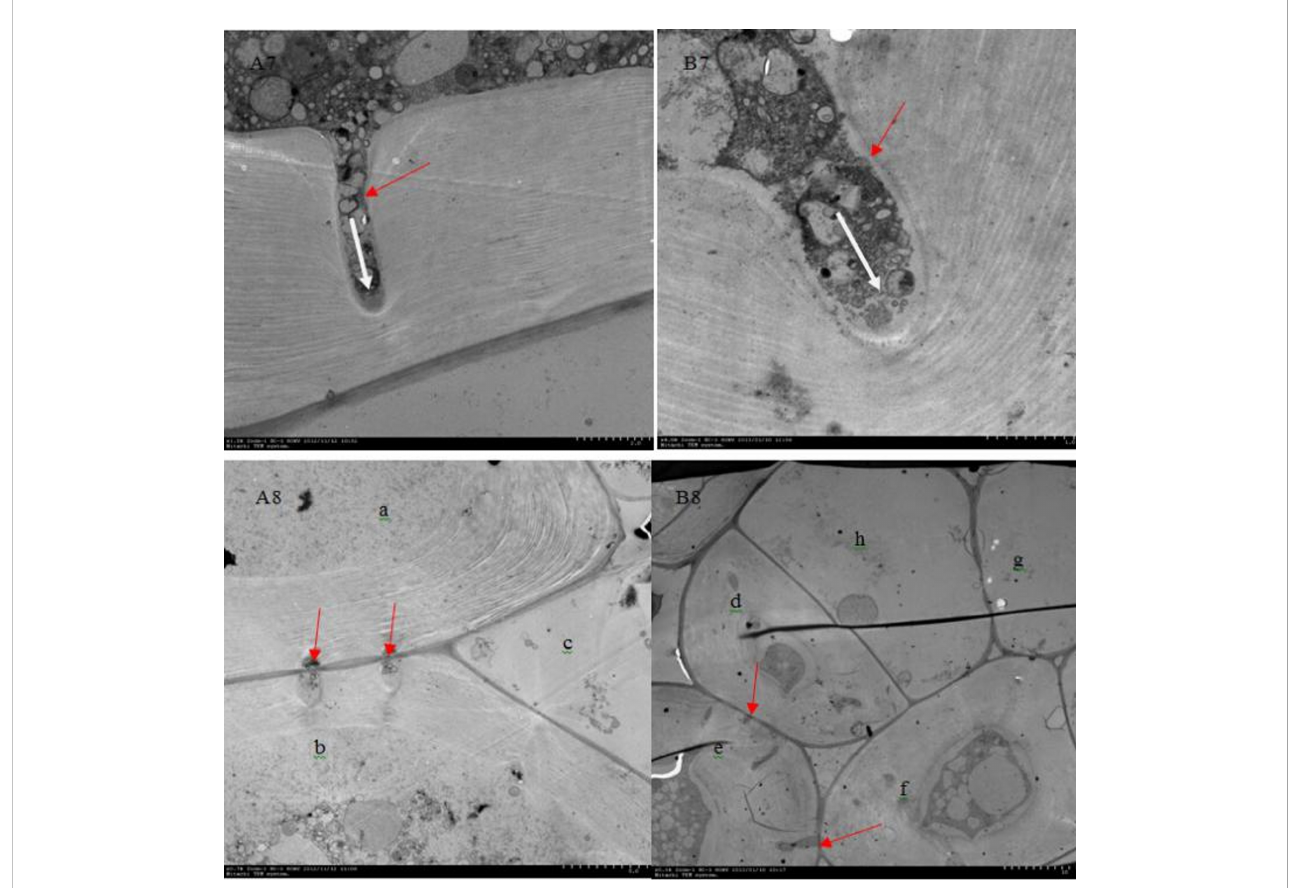
FIGURE 7 Ultramicroscopy of pits on pear stone cells of DY and DW. (A7, A8) was DY, (B7, B8) was DW. (A7, B7) Pits on the stone cells (short red arrow), the direction of material transport was from the intracellular to extracellular (short white arrow). (A8) ’ a ’ cell and ‘ b ’ cell were ligni fi ed parenchyma cells, ‘ c ’ cell was still parenchyma cell. There were two pit pairs between the ‘ a ’ cell and ‘ b ’ cell (short red arrow), but no pit pair between ‘ a ’ cell and ‘ c ’ cell or between ‘ b ’ cell and ‘ c ’ cell. (B8) ‘ d ’ cell, ‘ e ’ cell and ‘ f ’ cell were ligni fi ed parenchyma cells, ‘ h ’ cell an ‘ g ’ cell were just parenchyma cells. There was pit pairs between ‘ d ’ cell and ‘ e ’ cell as well as between ‘ e ’ cell and ‘ f ’ cell (short red arrow), but no pit pairs between ‘ d ’ cell and ‘ g ’ cell or between ‘ d ’ cell and ‘ h ’ cell or between ‘ f ’